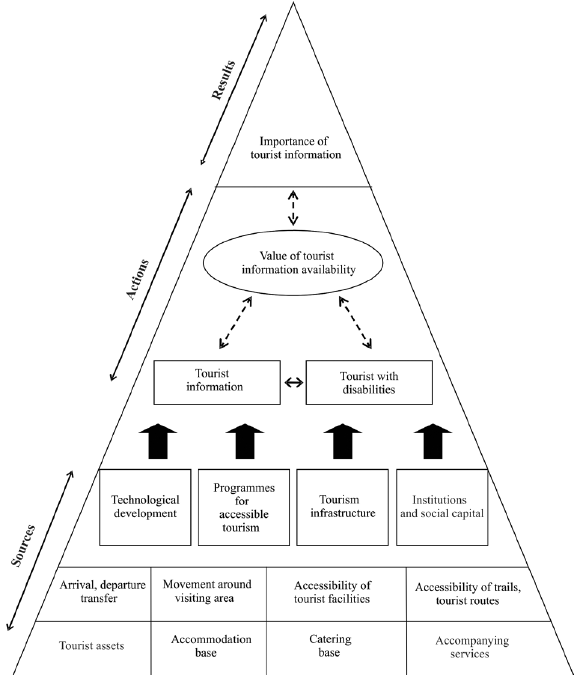
Fig. 3. Model of tourist information availability. Source: own